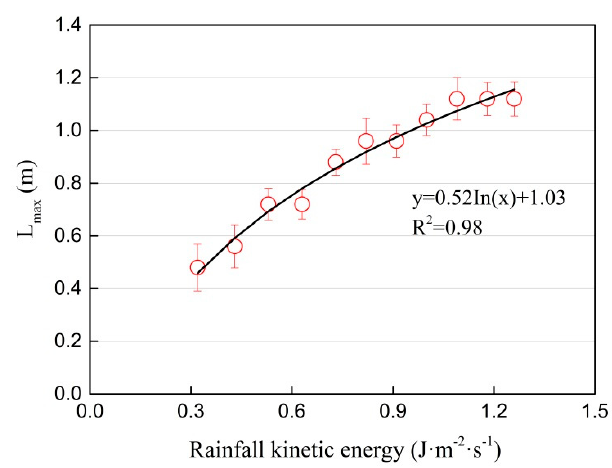
Figure 8. Relationship between maximum splash transport distance and rainfall kinetic energy.